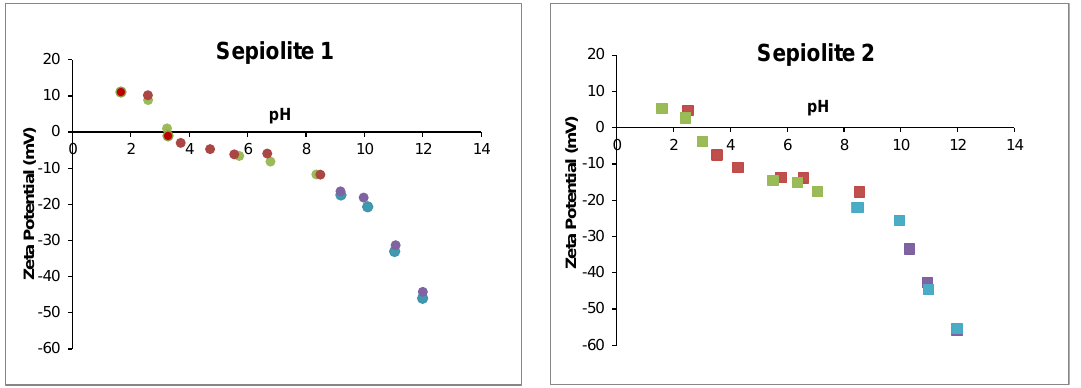
Figure 5. Zeta potential as a function of pH for the sepiolite 1 and sepiolite 2 samples (different series of measurements were performed, each one shown by a different color).